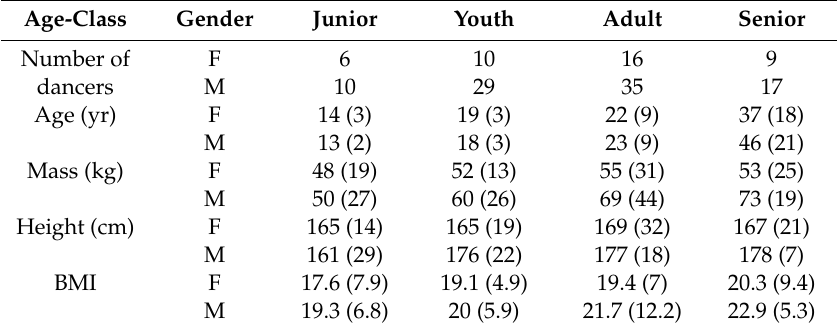
Table 1. Descriptive characteristics of participants by di ff erent gender and